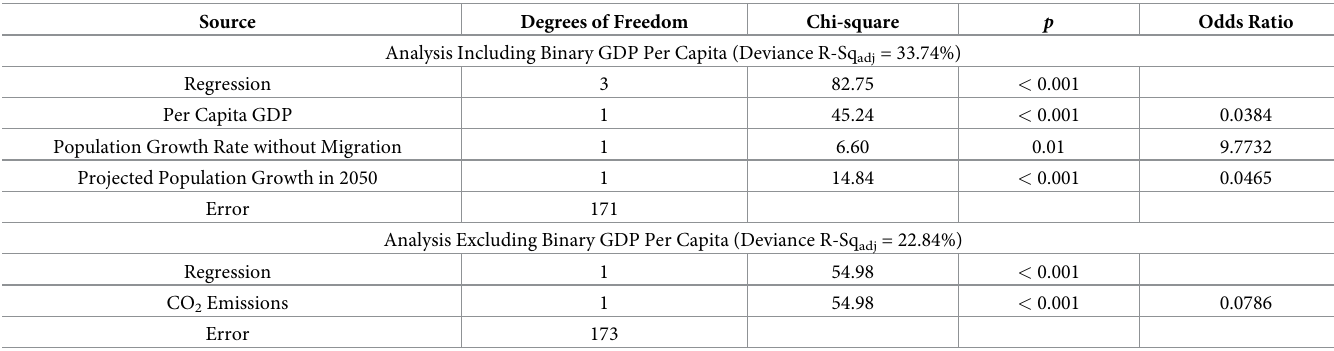
Table 2. Statistically significant predictors (defined in Table 1) of migration status. Source Degrees of Freedom